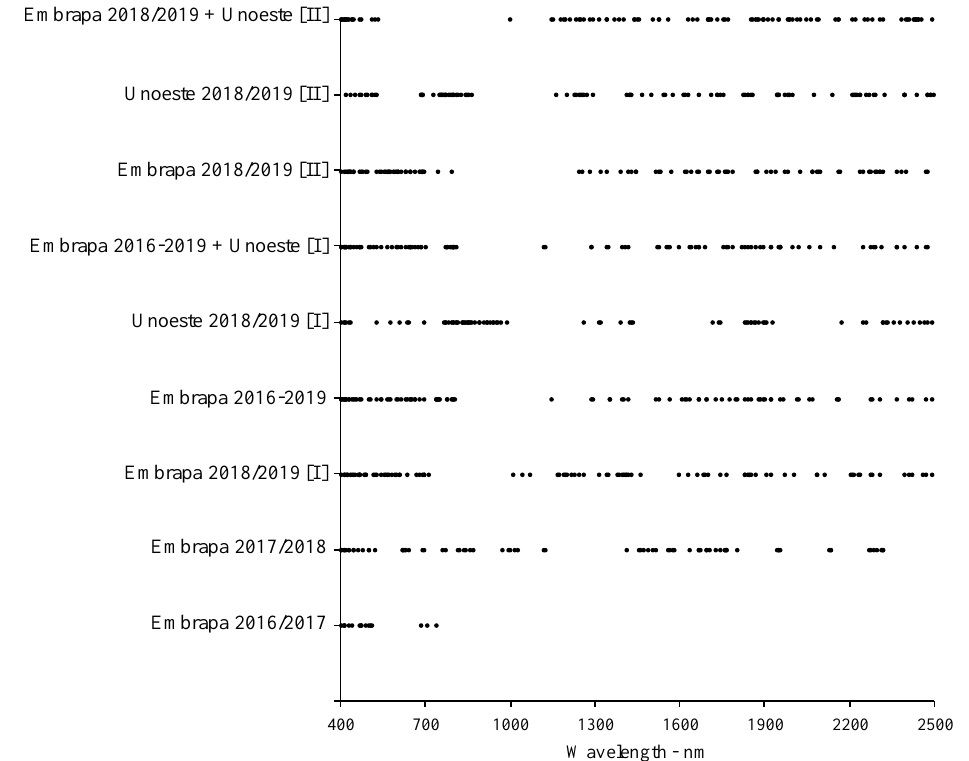
Figure 8. Principal component analysis of each spectral dataset.